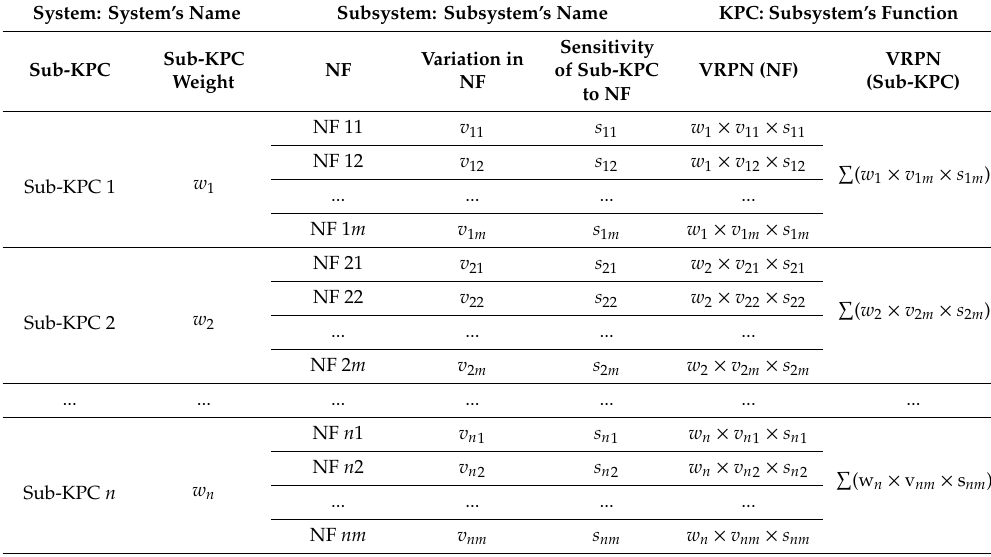
Table 2. Variation and Mode E ff ect Analysis (VMEA) form.